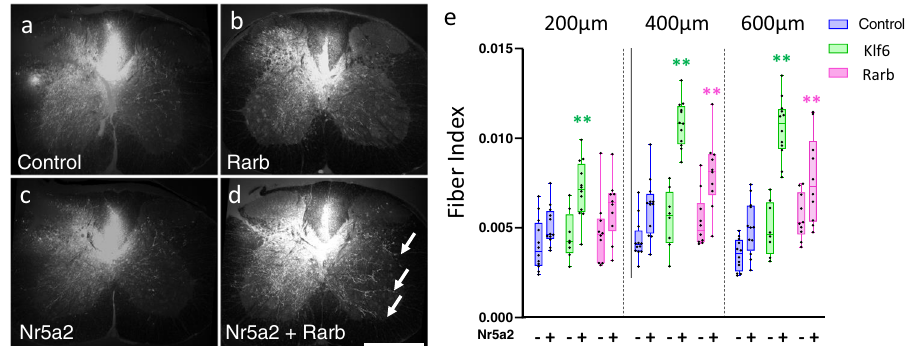
Fig. 4 Nr5a2 synergizes with Rarb to promote CST growth. a – d Adult mice received cortical AAV delivery of single or combinatorial TFs and contralateral pyramidotomy. Co-injected AAV-tdTomato-labeled CST axons. Elevated cross-midline sprouting of CST fi ber is evident in animals treated with combined Nr5a2 and Rarb (arrows, d ). e Cross-midline growth of CST axons was quanti fi ed in transverse spinal sections. Nr5a2 administered alone had no signi fi cant effect on axon growth (blue bars), but increased axon growth when combined with either Klf6 or Rarb, signi fi cantly above the level of either alone (green and pink bars, respectively). [** p < 0.01 (K + N 200 µ m = 0.0012, K + N 400 µ m = 0.0001, K + N 600 µ m = 0.0001, K + R 400 µ m = 0.0007, K + R 600 µ m = 0.0136, two-way ANOVA, post hoc Dunnett ’ s]. Scale bar is 500 µ m. n is between 10 and 14 animals per group. PKC γ , medulla, and spinal images from all animals are in Supplementary Figs. 2 – 5. Box plots represent median and IQR (25th to 75th percentile), and whiskers extends to the maximum and minimum values. Dots in e represent values of single animals. Source data are provided as a Source data fi